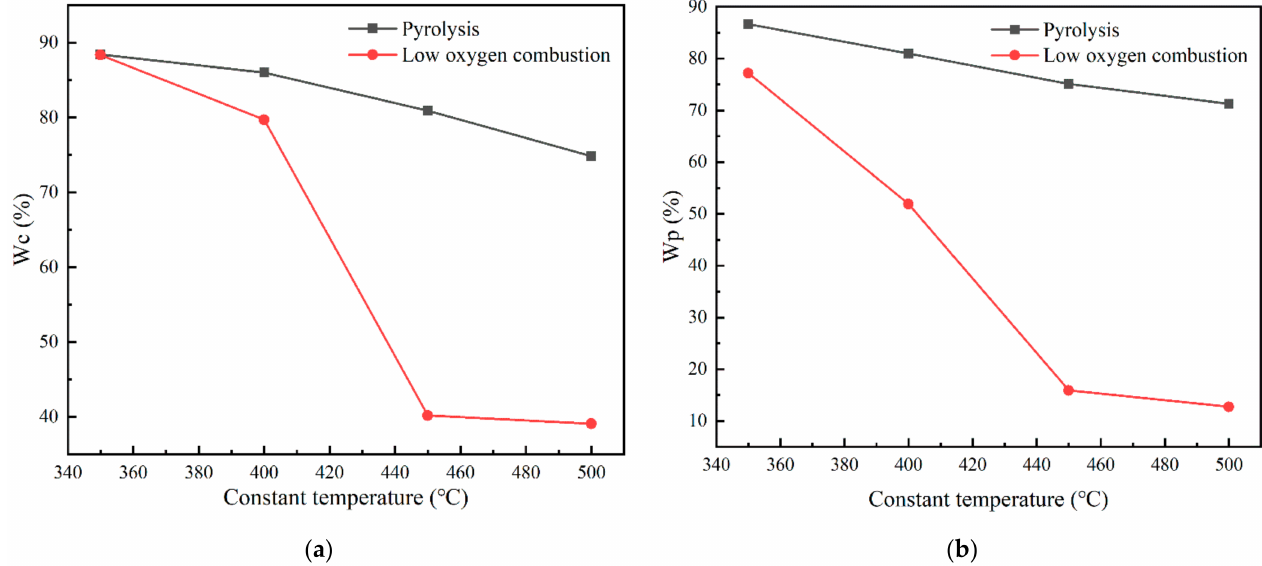
Figure 2. The variety law of characteristic parameters in different constant temperatures. ( a ) The parameter is constant temperature starting point of residual value, Wc . ( b ) The parameter is residual weight end value, Wp